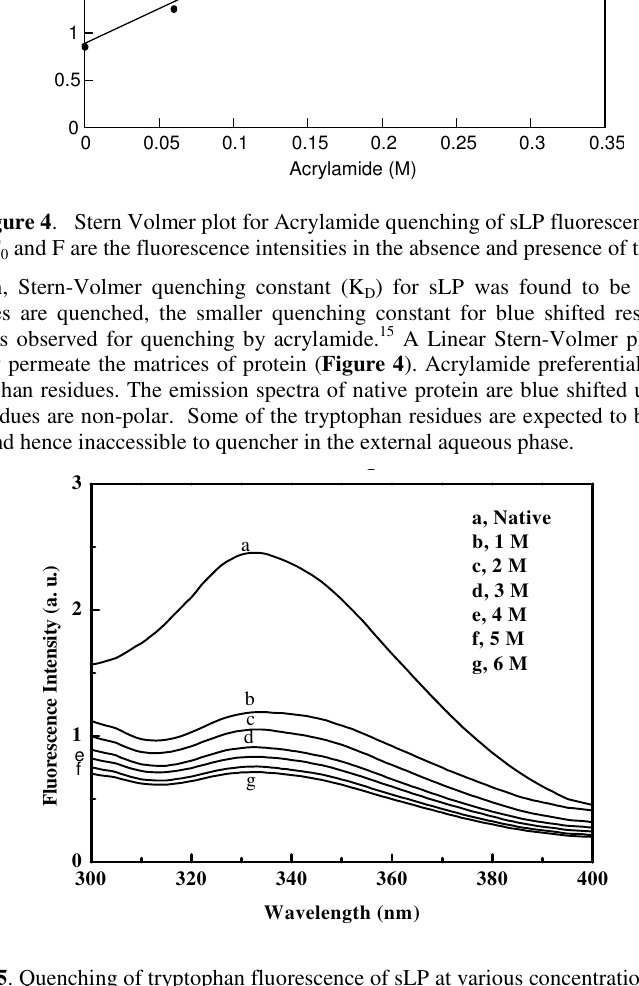
Figure 5 . Quenching of tryptophan fluorescence of sLP at various concentrations of KI (a) Native sLP (b) 0.05M (c) 0.1M (d) 0.15M (e) 0.2M (f) 0.25M (g)